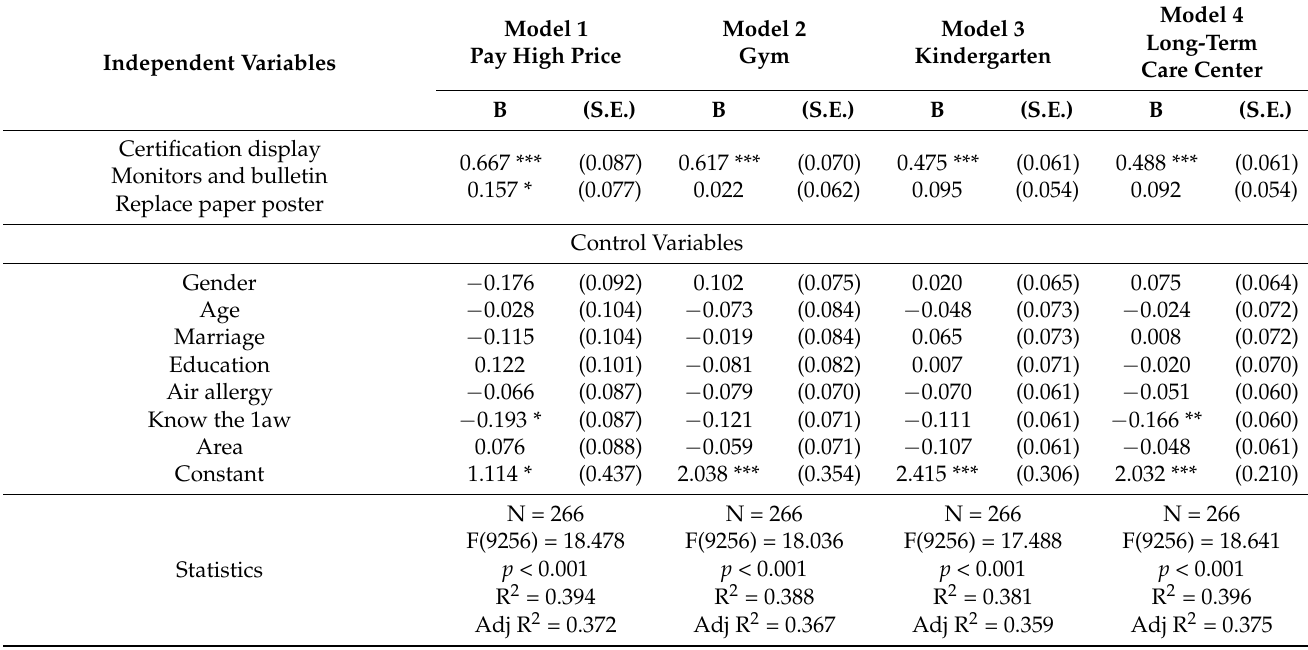
Table 10. Certification display regression.